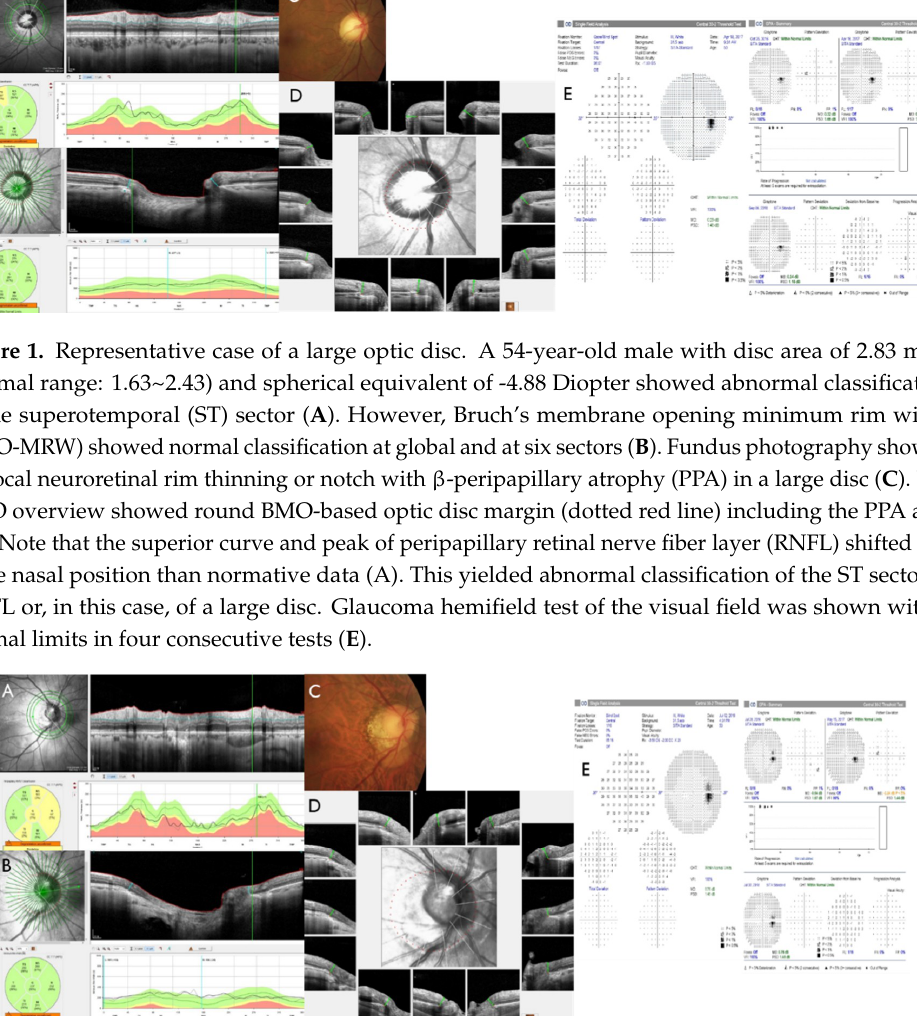
Figure 2. Representative case of myopia. A 53-year-old male with a spherical equivalent of ×7.75 Diopter and disc area of 2.58 mm 2 (normal range: 1.63~2.43) showed an abnormal classification at inferotemporal (IT) and superonasal (SN) sectors with a global classification of borderline ( A ). However, Bruch’s membrane opening minimum rim width (BMO-MRW) showed normal classification at global areas and at six sectors ( B ). Fundus photography showed peripapillary atrophy (PPA) and tilted myopic optic disc ( C ). Spectral-domain optical coherence tomography showed β-PPA along with γ-PPA as border tissue without Bruch’s membrane (B, D ). The BMO overview showed round BMO-based optic disc margin (dotted red line) including the PPA area. Note that the superior curve and peak of peripapillary retinal nerve fiber layer (RNFL) shifted to a more temporal position than normative data (A). This yielded abnormal classification of the SN sector of RNFL for myopia. Glaucoma hemifield